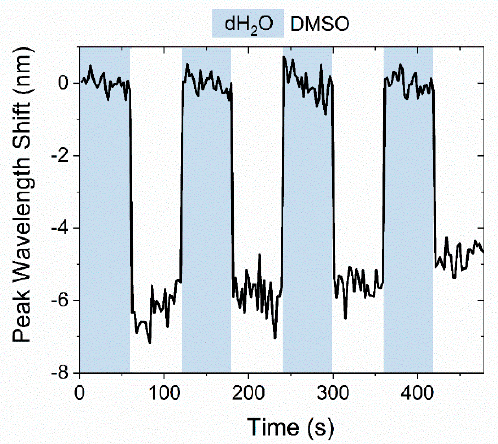
Figure 5. Peak wavelength shift of the Au-TiO 2 thin film (annealed at 150 ° C), during H 2 O/DMSO cycles.